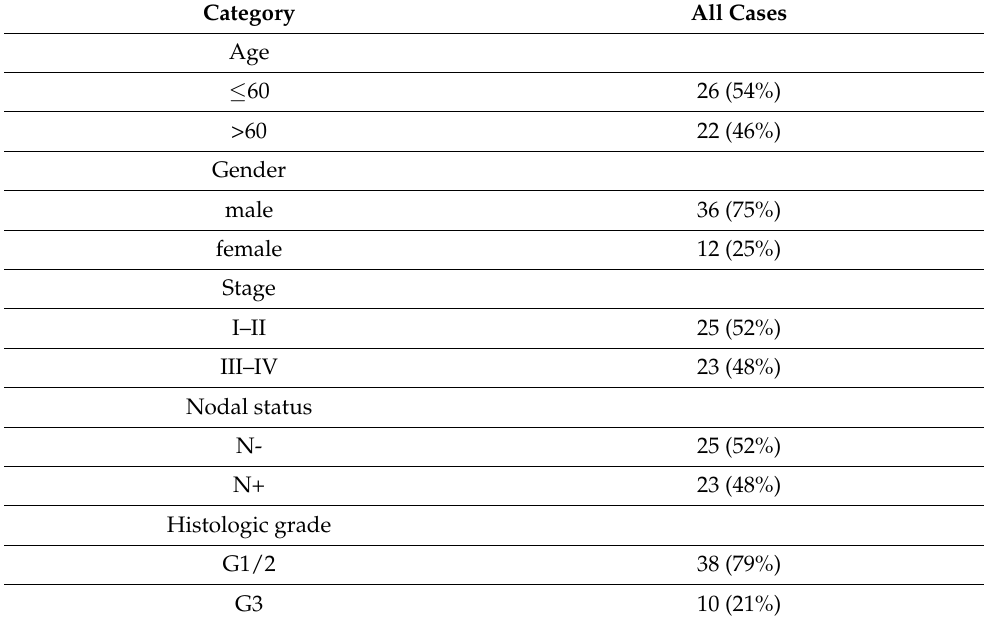
Table 1. Study population. Category All